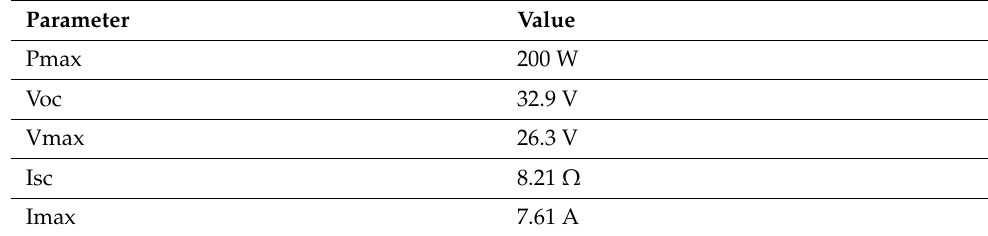
Table 1. Photovoltaic module parameters